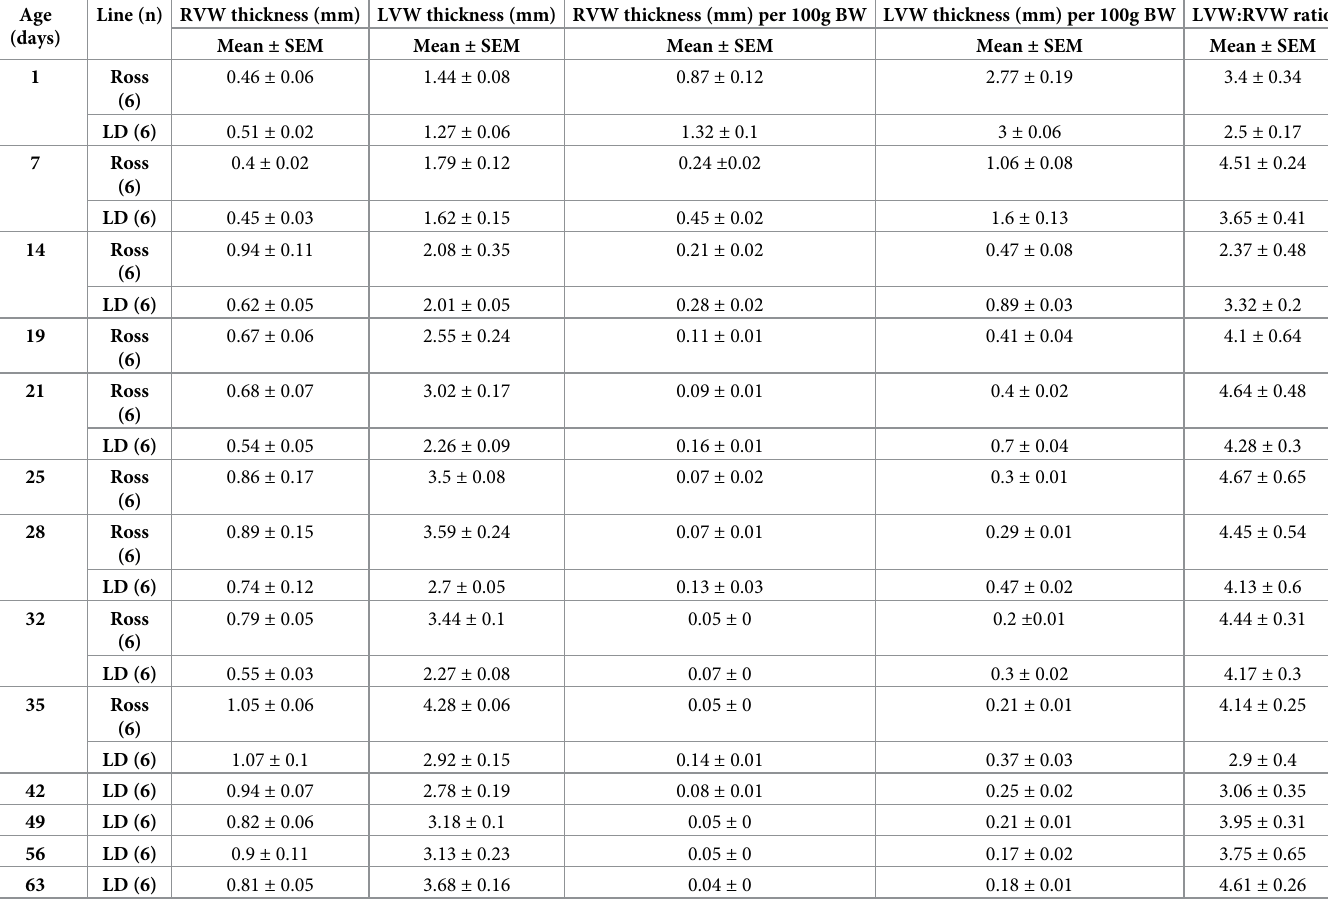
Table 2. Ventricular wall measurements over time of both chicken